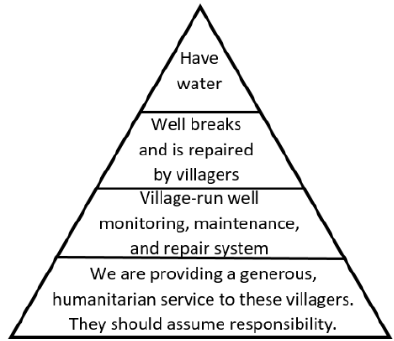
Fig. 33. Ayolé Iceberg model—Engineers' perspective